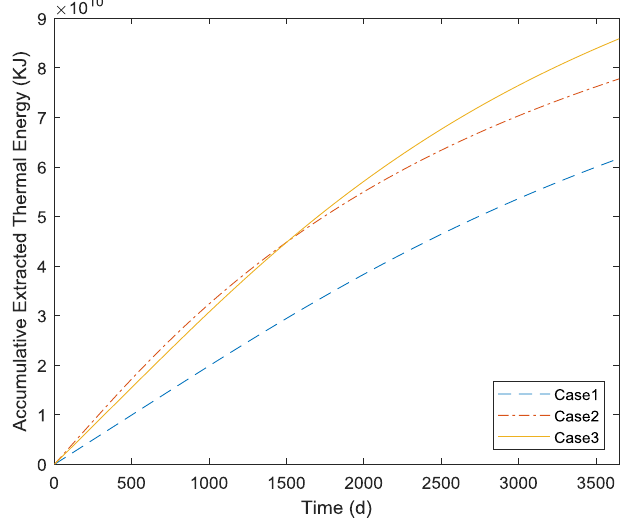
Figure 11. The accumulative extracted thermal energy in the three cases.